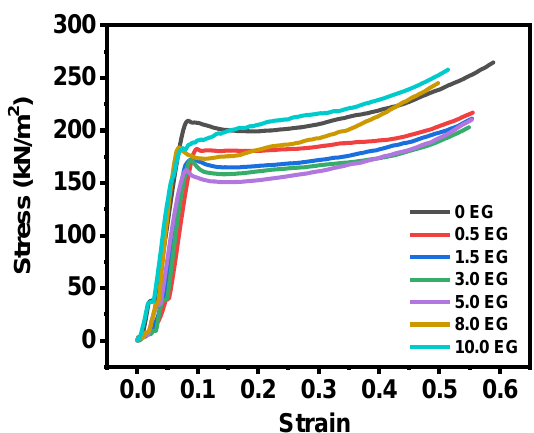
Figure 9. Compressive strength for carvone-based PU with an increasing amount of EG.